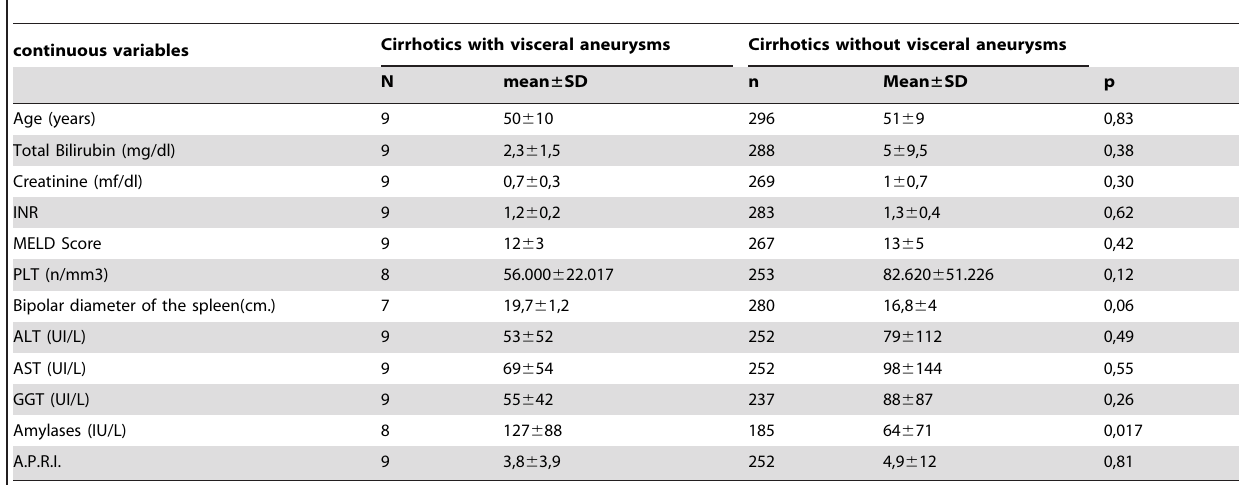
Table 1. Univariate analysis of continuous variables among cirrhotics waiting for LT, with and without visceral aneurysms.